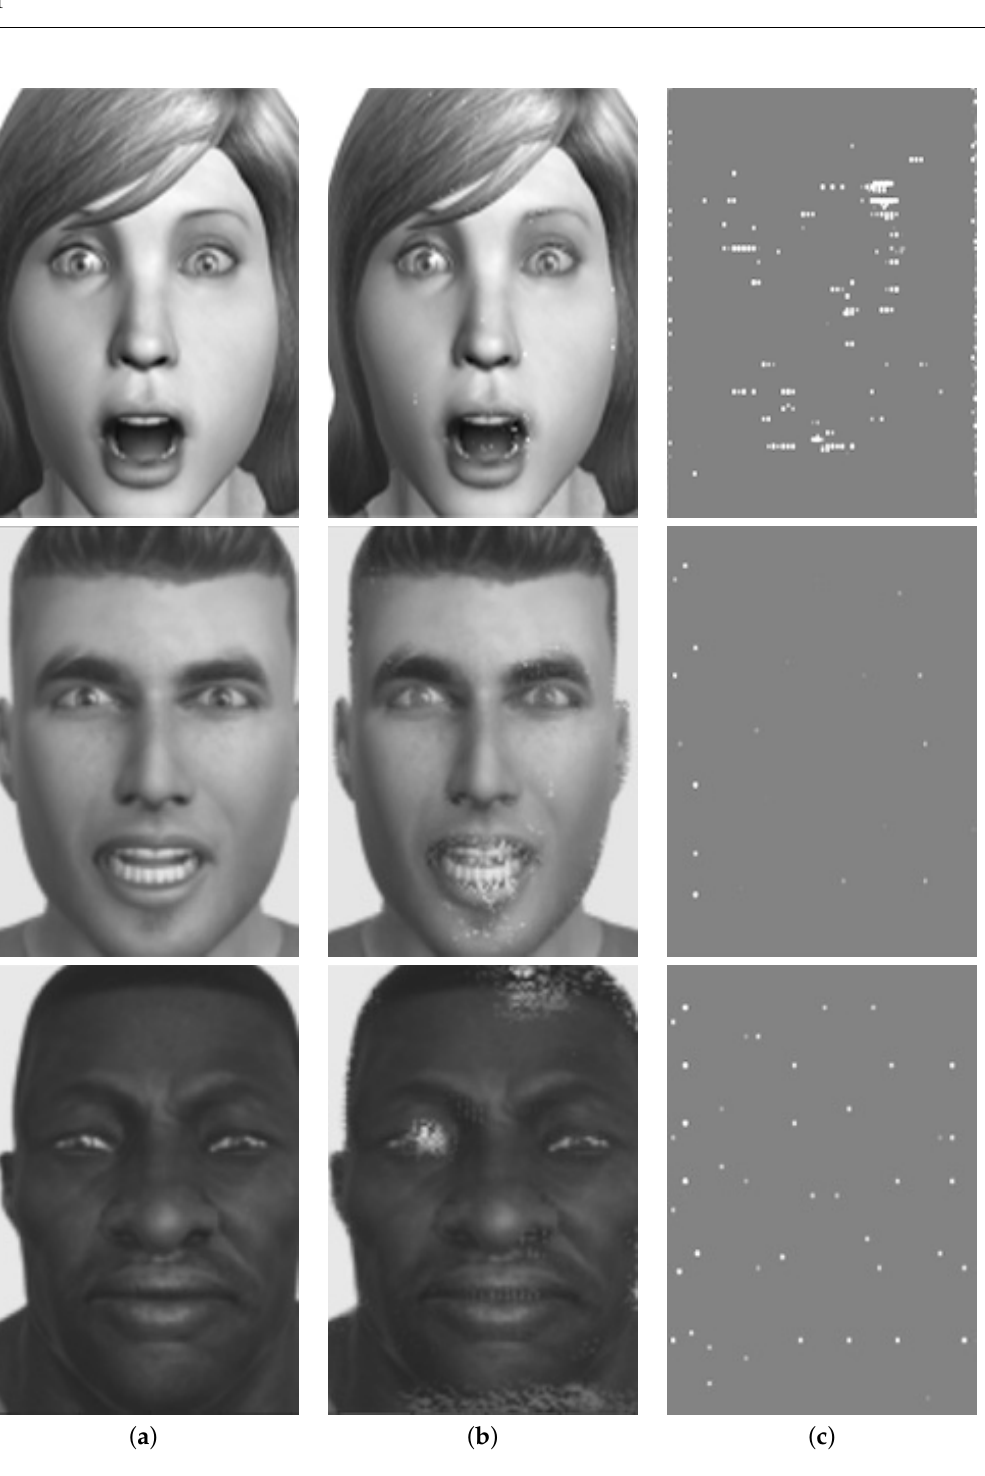
Figure 10. Results of applying CEM to a grayscale input image ( a ) showing the ( b ) explanation of the pertinent negatives and the ( c ) explanation of the pertinent